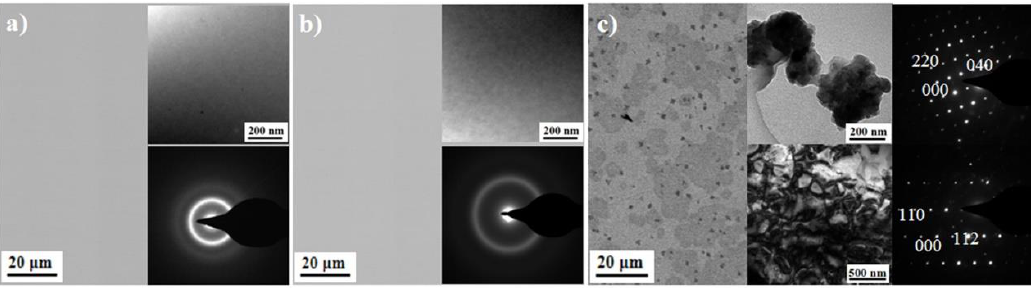
Figure 4. SEM and TEM images, together with the SAED patterns of the samples after creep tests at 100 MPa with different temperatures: ( a ) 660 K, ( b ) 680 K, and ( c ) 700 K.